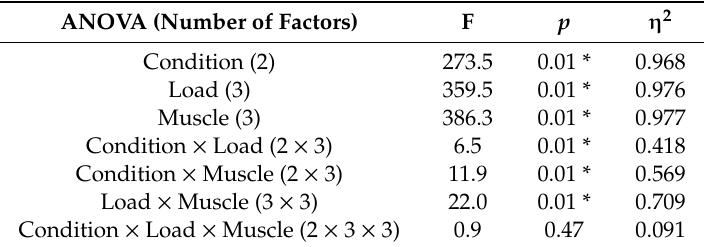
Table 1. The results of a three-way repeated measures